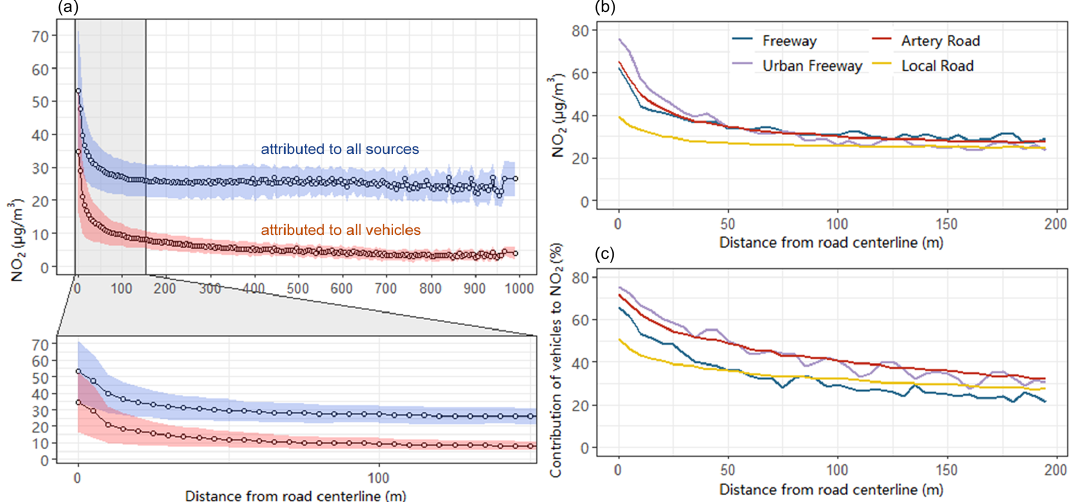
Figure 12. Monthly averaged NO 2 concentrations attributed to all emission sources or vehicles with a distance from the receptor to its nearest road centerline. (a) NO 2 attributed to all emission sources near all roads. (b) NO 2 attributed to all emission sources near different road types. (c) Relative contribution of vehicles to NO 2 near different road types. The shaded area in (a) represents the standard deviation in the results of all